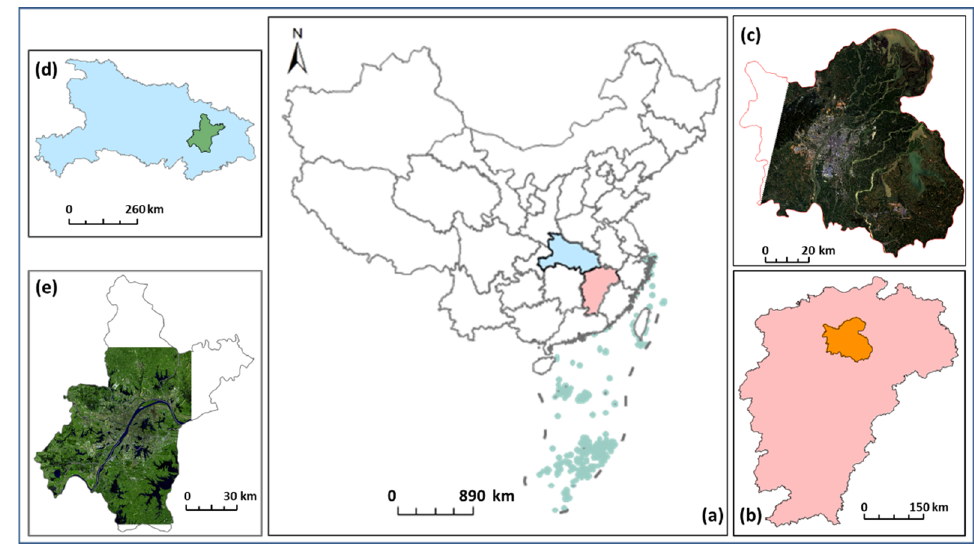
Figure 1. The study area. ( a ) The location of Jiangxi and Hubei province in China; ( b ) the location of Nanchang in Jiangxi province; ( c ) the Landsat image used in this research for Nanchang, from a Landsat 8 OLI image from 09/14/2017; ( d ) the location of Wuhan in Hubei province; ( e ) the Landsat image used in this research for Wuhan, from a Landsat 8 OLI image from 09/15/2018.